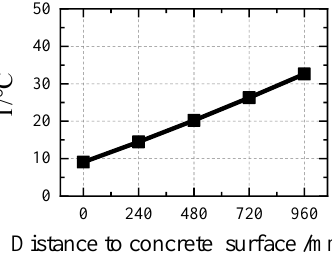
Figure 3. Temperature field of the TPC during normal operation. ( a ) Internal concrete; ( b ) Concrete roof; ( c ) Inner and outer steel plates; and ( d ) Stud.